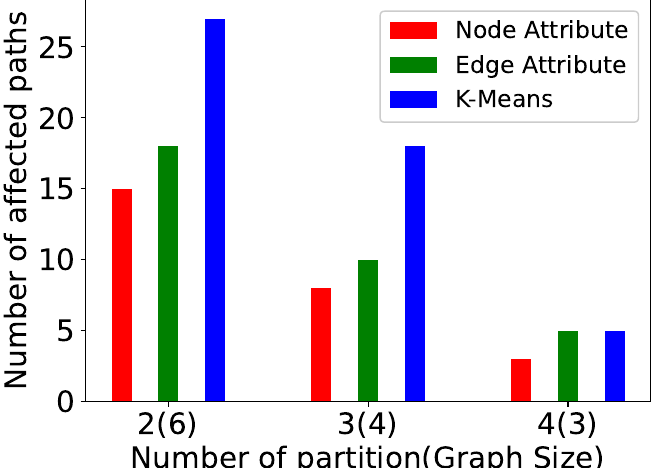
Figure 16. Paths computed in P-TSP for a varied number of partitions.